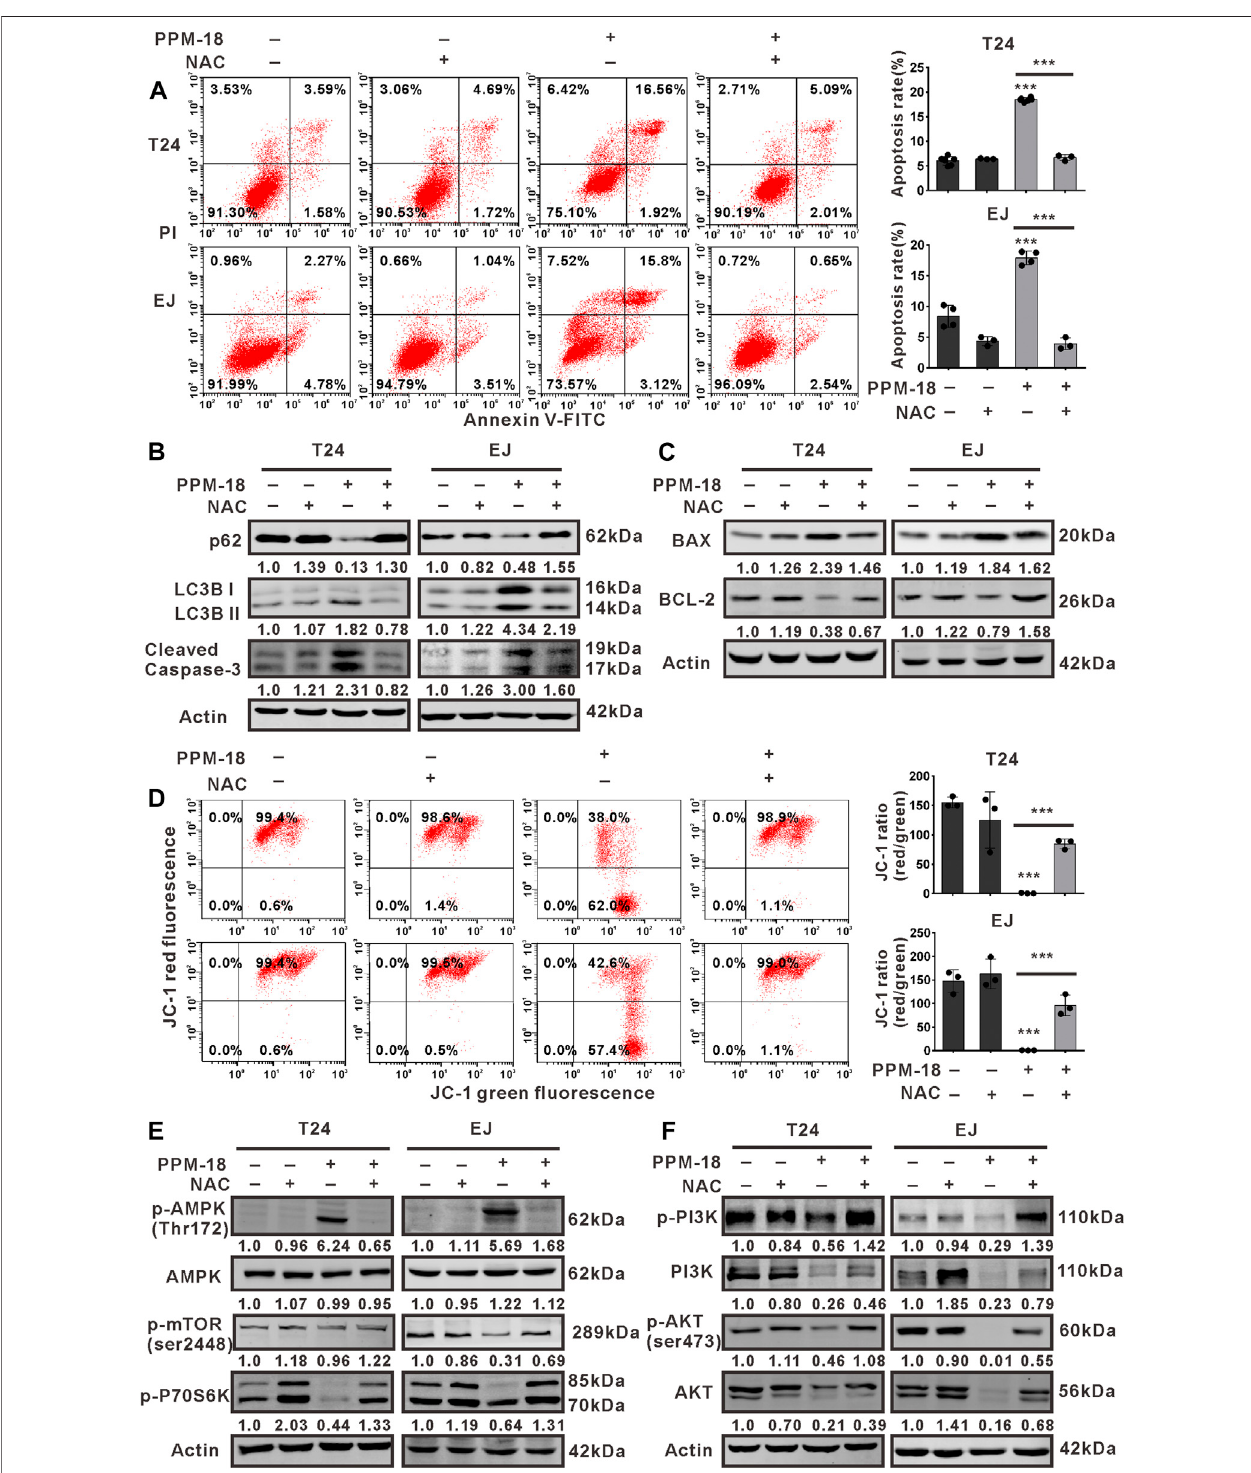
FIGURE 6 | ROS production is required for AMPK-dependent autophagy and apoptosis in PPM-18 – treated bladder cancer cells. (A) Flow cytometry showed the effect of NAC on PPM-18 – triggered apoptosis in T24 and EJ cells. (B) and (C) Western blot demonstrated that treatment with NAC in fl uenced the expression of p62, LC3B, cleaved caspase-3, BAX, and BCL-2 in T24 and EJ cells treated with or without PPM-18. (D) Flow cytometry displayed the effect of NAC on the collapse of mitochondria membrane potential in PPM-18 – treated T24 and EJ cells. (E) and (F) Western blot demonstrated the effect of NAC on AMPK activation and PI3K/ AKT/mTORC1pathwayssuppressioninPPM-18 – treatedT24andEJcells.Dataarepresentedasthemean ± SDofatleastthreeindependentexperiments.*** p < 0.001 vs. the control group or vs.